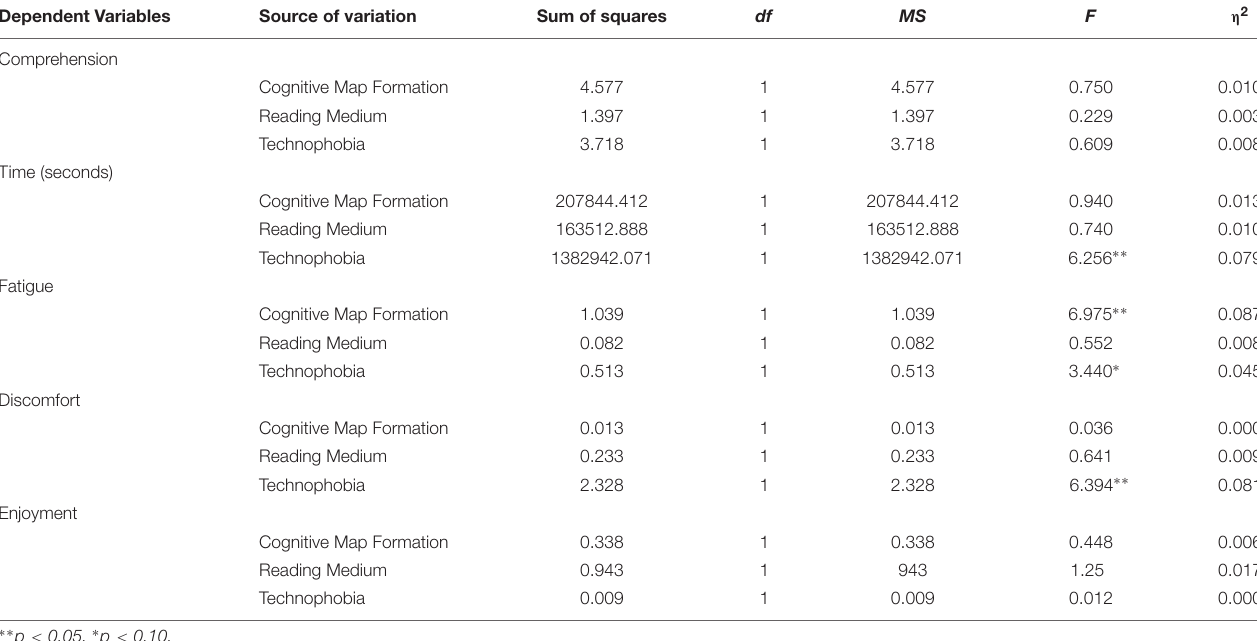
TABLE 2 | ANCOVA analysis on cognitive map formation, reading medium, and technophobia.